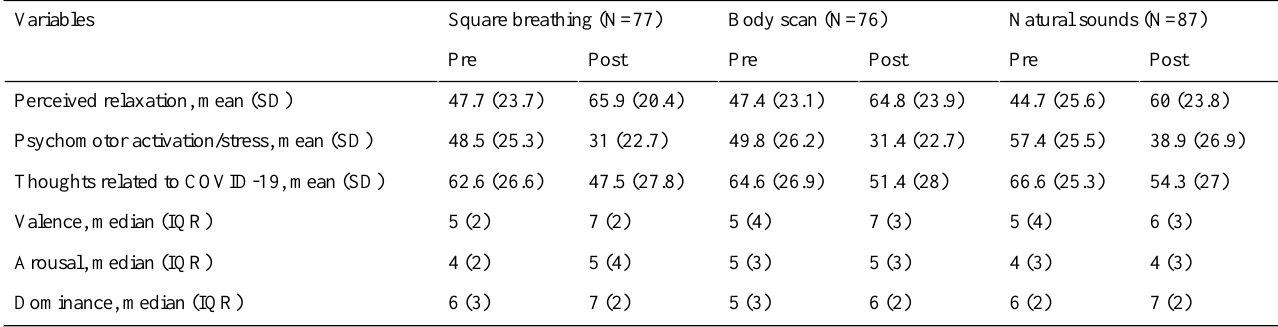
Table 4. Descriptive statistics of assessed pre-post variables for each